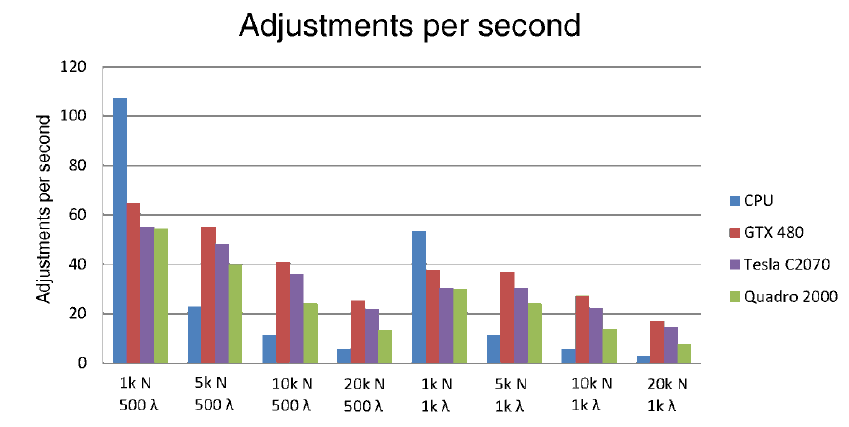
Figure 4. The rate of adjustments per second performed by different GPU devices and the CPU with different numbers of neurons and input patterns (k indicates